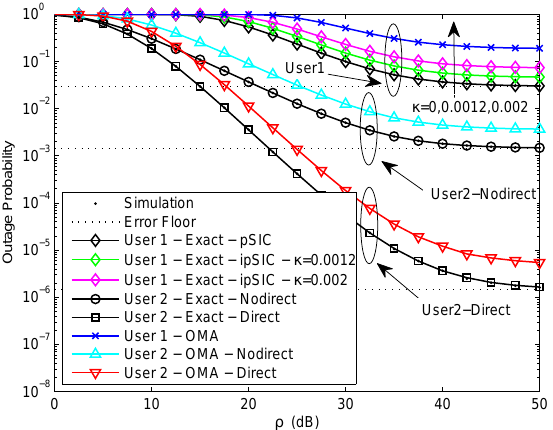
Figure 3. Outage probability versus transmit SNR with different levels of RI .